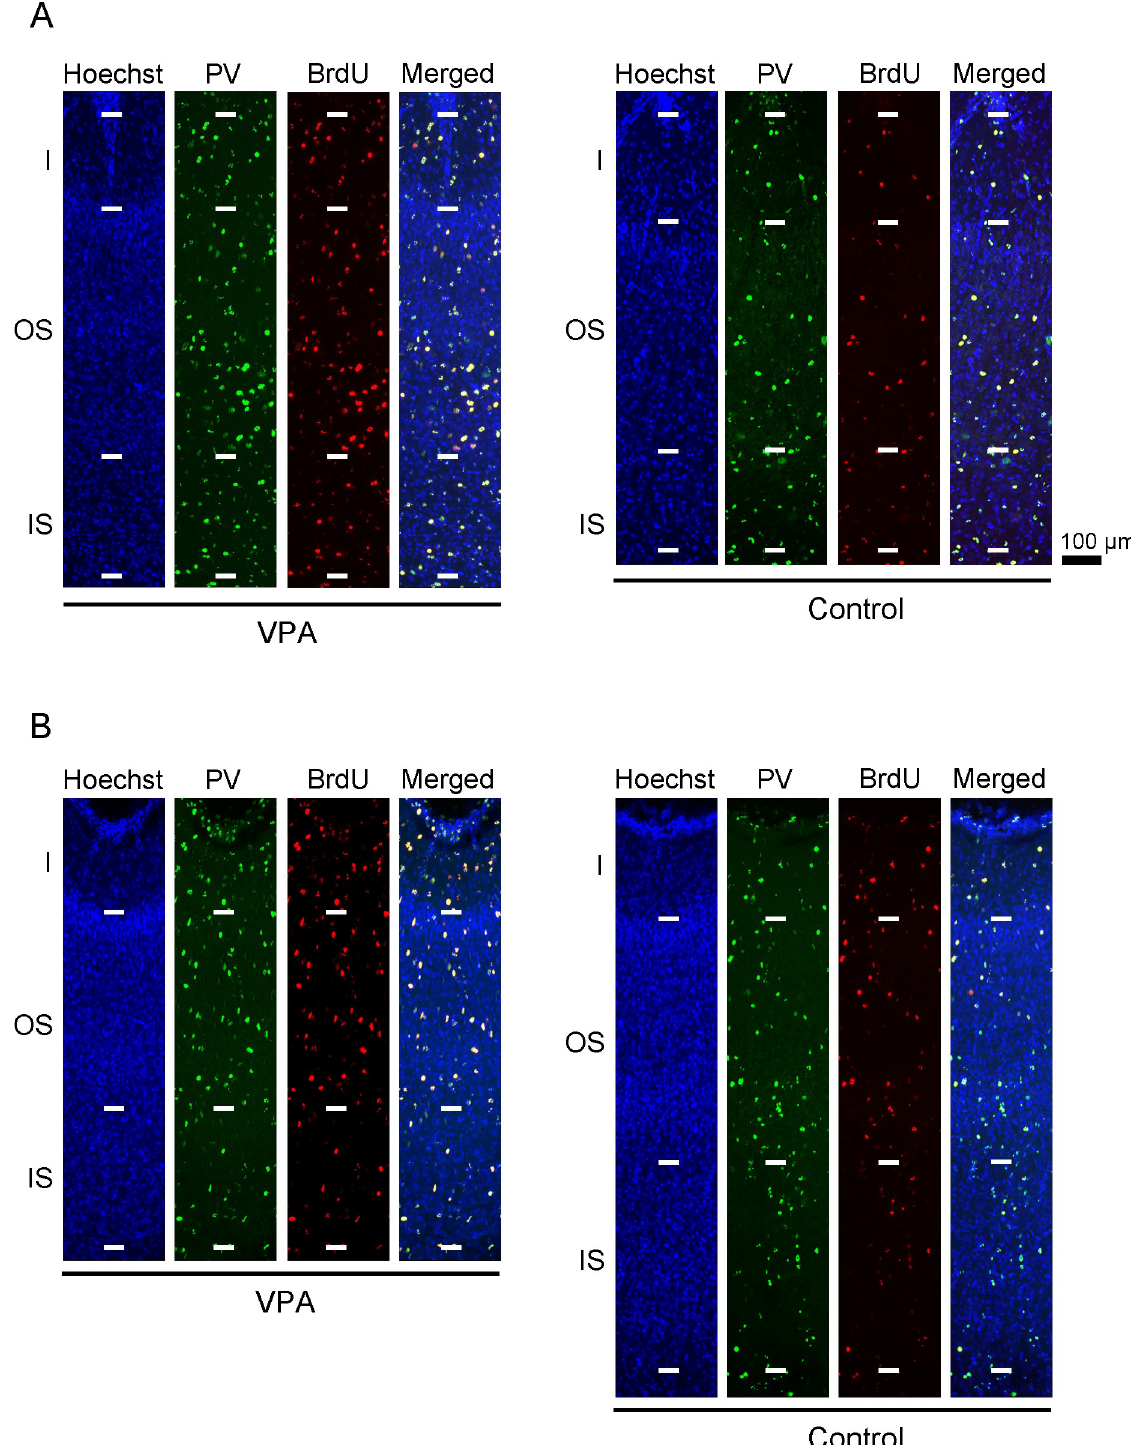
Fig 3. Parvalbumin neuron immunofluorescence with BrdU labeling and Hoechst staining in sulcal floors of the cerebral cortex of VPA-treated and control ferrets at PD 20. (A) Cortical depth of the rostral sylvian sulcus (rsss) floor. (B) Cortical depth of the lateral sulcus (ls) floor. The rsss and ls were selected as representative sulci with cortical floors that were thickened or thinned by neonatal VPA exposure, respectively. PV, parvalbumin.